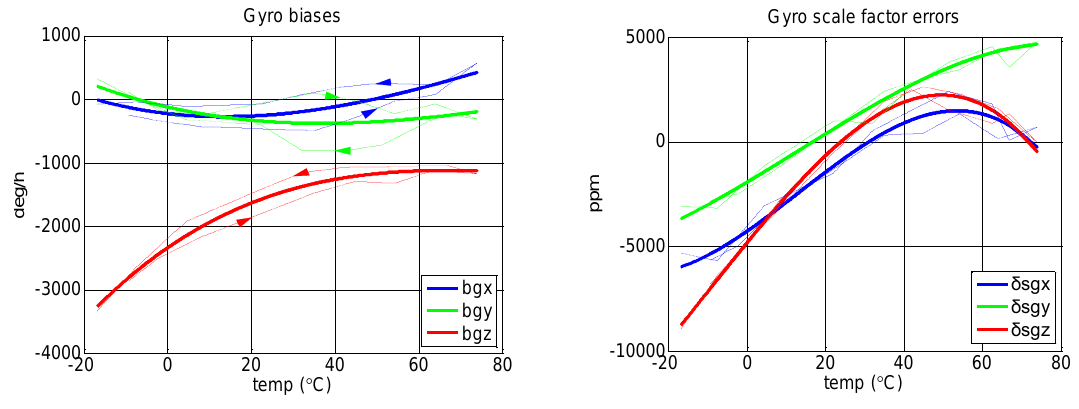
Figure 6. Thermal calibration results of MTi-G gyro biases and scale factor errors with Soak method. The thin solid lines are the results under separated heating and cooling processes (rightward and leftwards arrows indicate heating and cooling processes, respectively). The thick lines are the final curve fitted result (3rd-order polynomial fit).